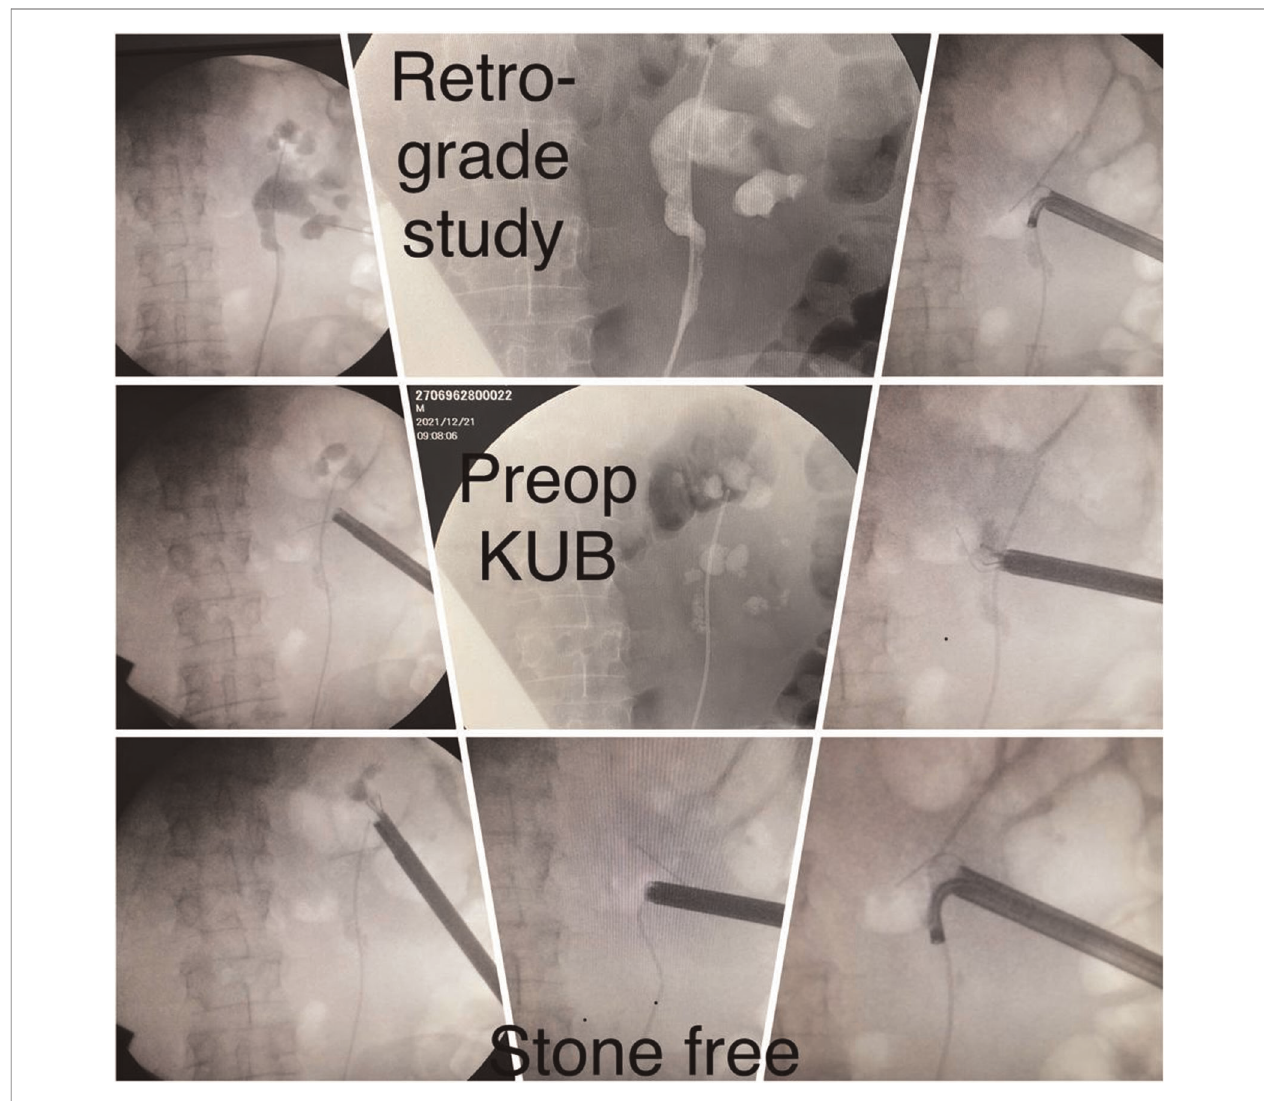
FIGURE 4 | Images from